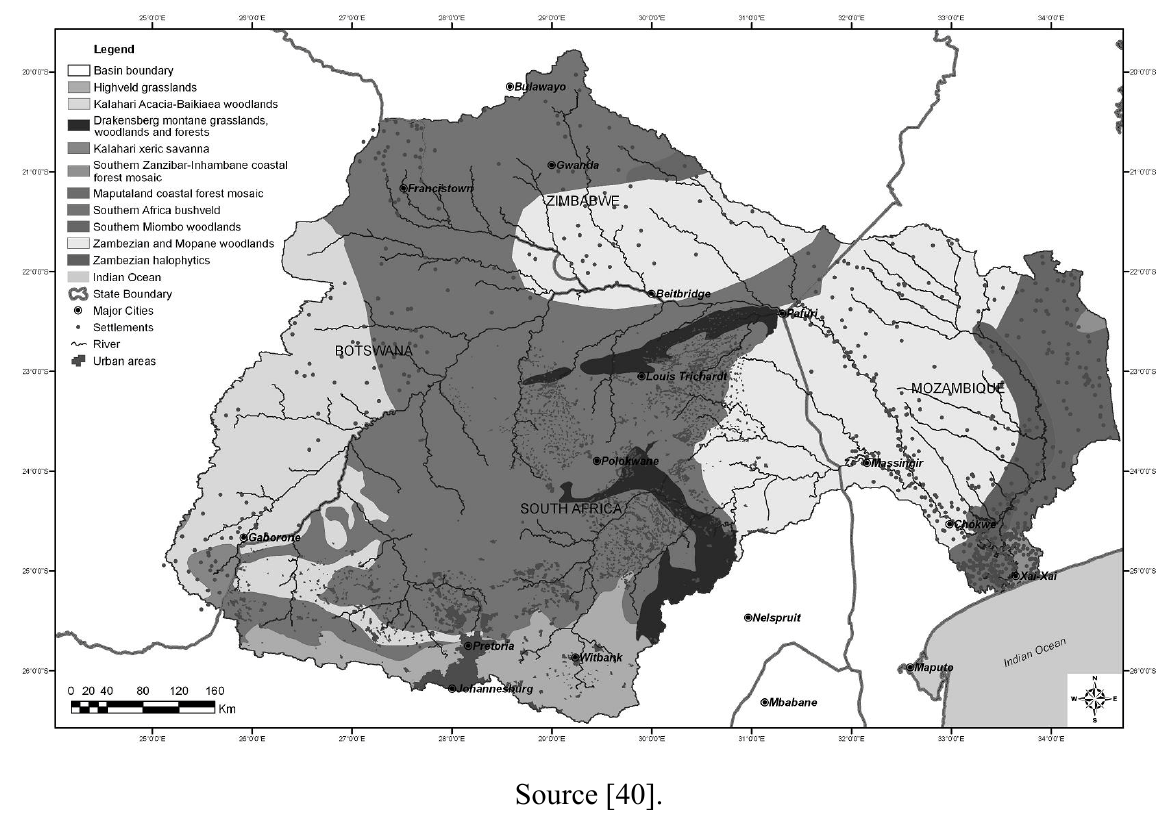
Figure 3. Human settlements and ecosystems in the Limpopo